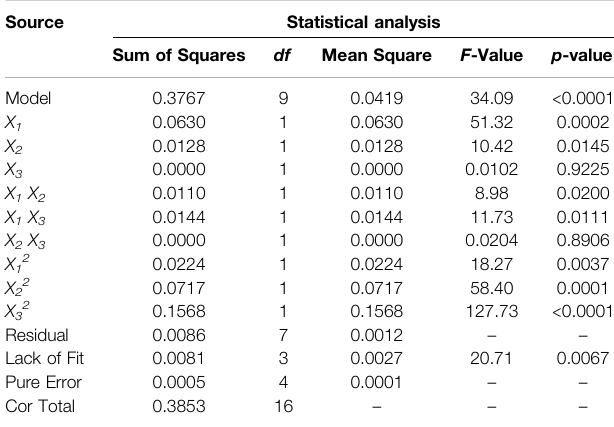
TABLE 2 | Sequential model fi tting for the yield of CSP.